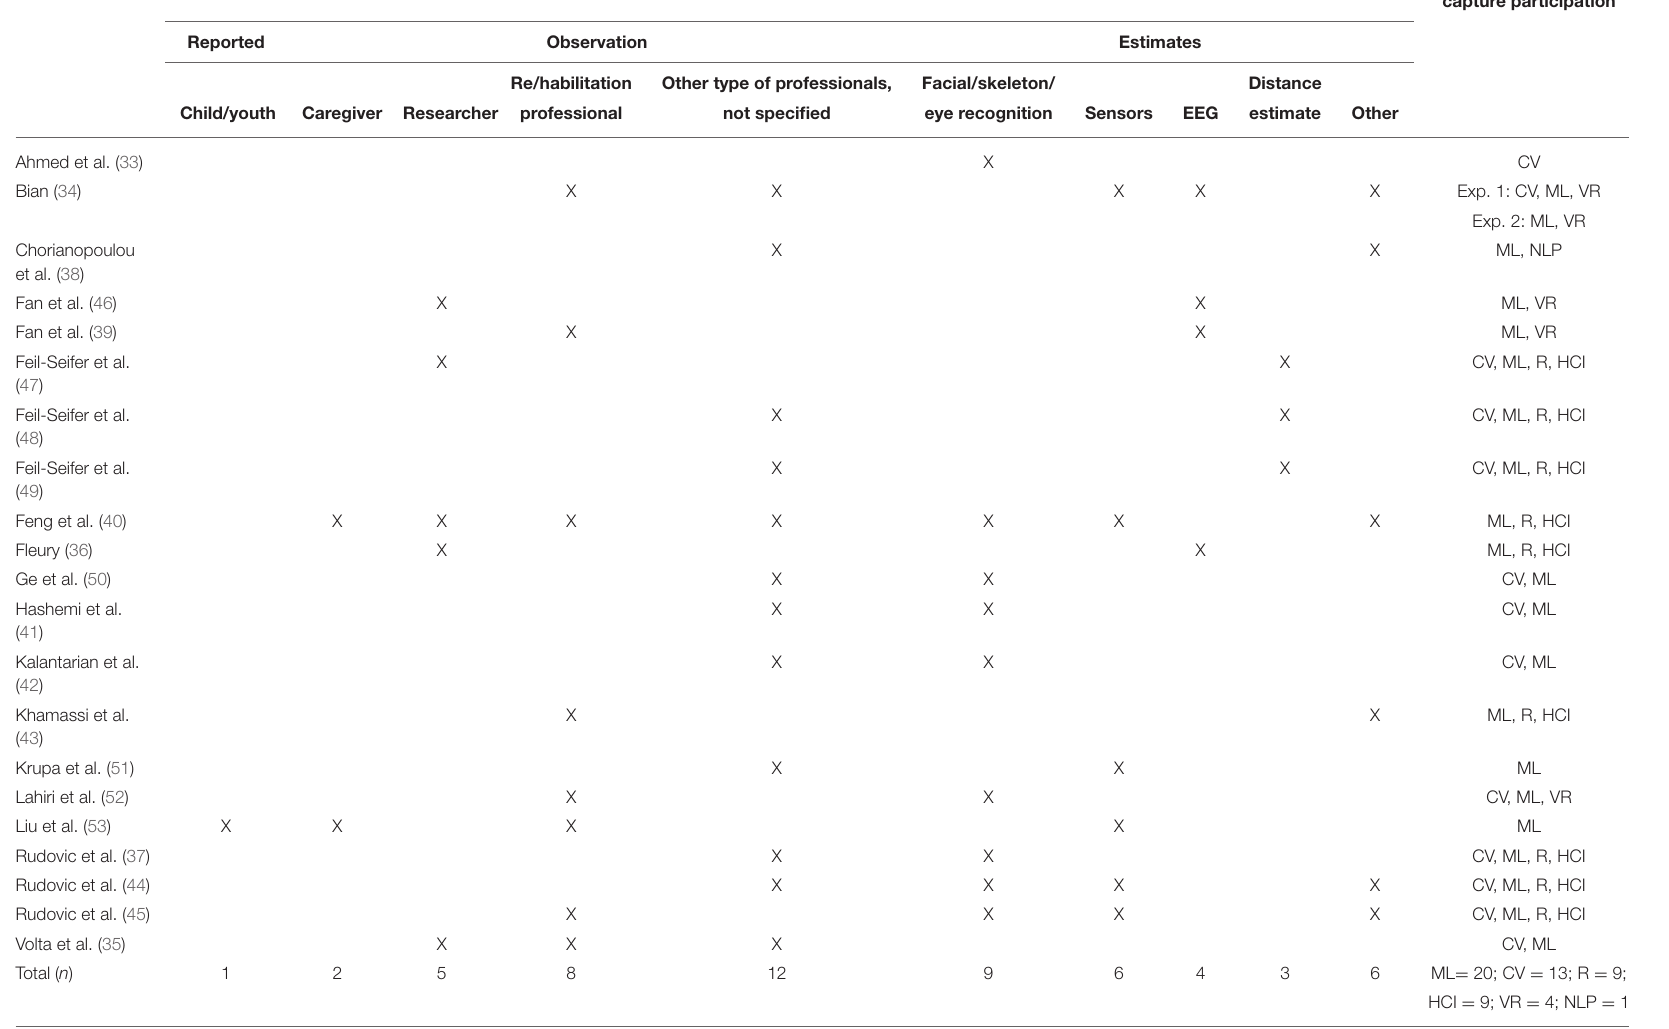
TABLE 2 | Data collection, data source, and type(s) of AI